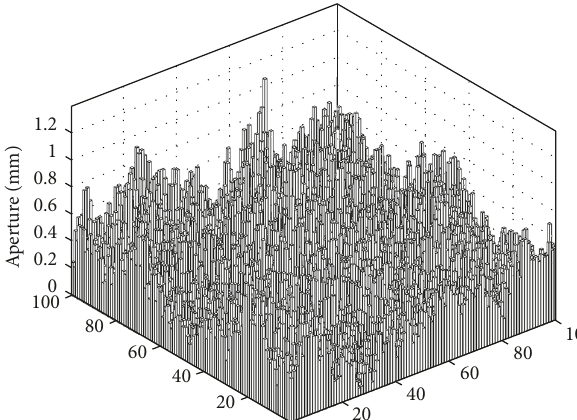
Figure 3: Random aperture field of the fracture ( 𝑢 = 0.4 mm, 𝜎 = 0.14 mm, and 𝜆 = 5.6